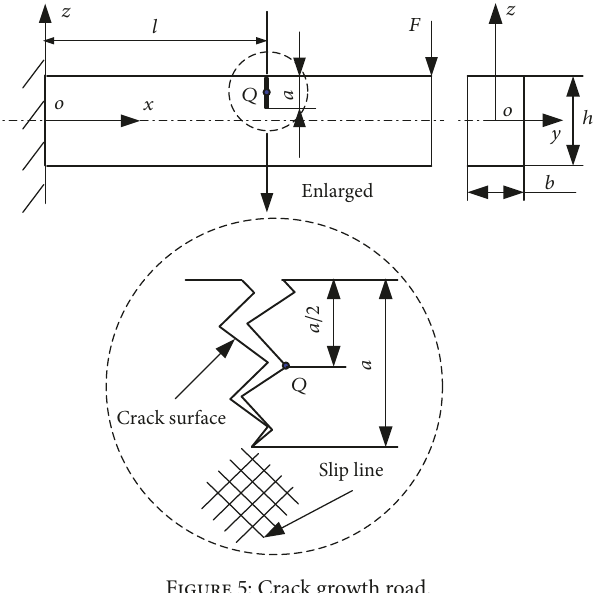
Figure 5: Crack growth road.